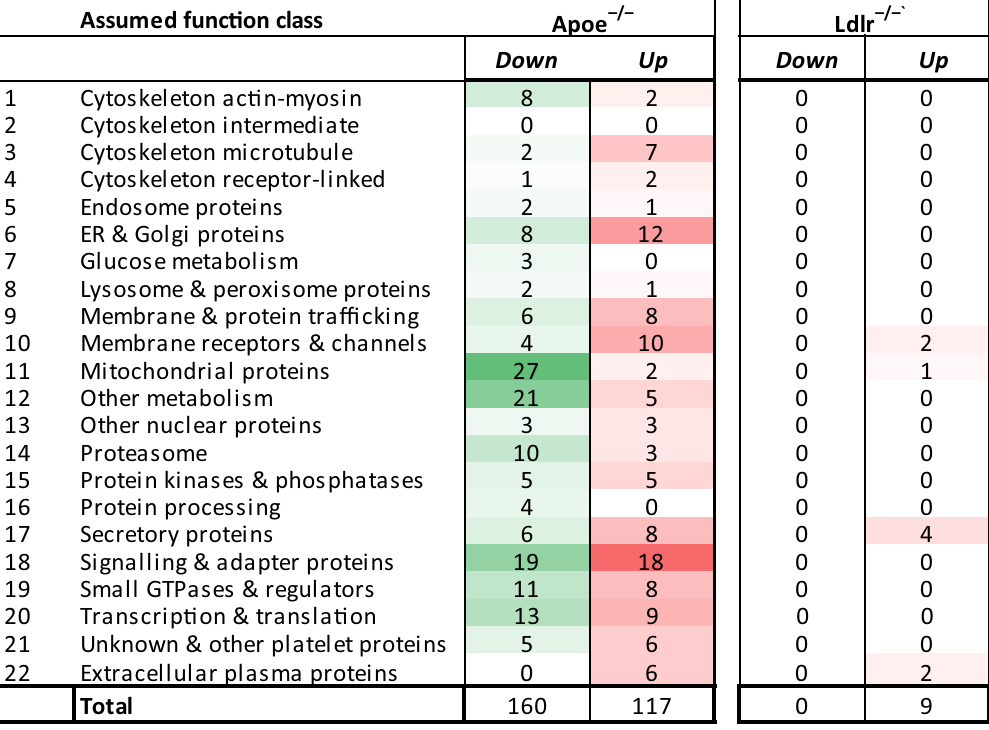
Table 1. Overview of differences in quantitative proteome of ApoE- and LDLR-deficient platelets as compared to wild-type platelets. Highly purified platelets from wild-type, Apoe −/− and Ldlr −/− mice were subjected to label-free proteomics analysis. Ratios of 1,533 unique proteins were quantified by mass spectrometry (see “Methods”). Unique proteins of the quantitative proteome were assigned to 22 assumed function classes. Green represents > 1.5 fold downregulated and red > 1.5-fold upregulated proteins. N = 3–4